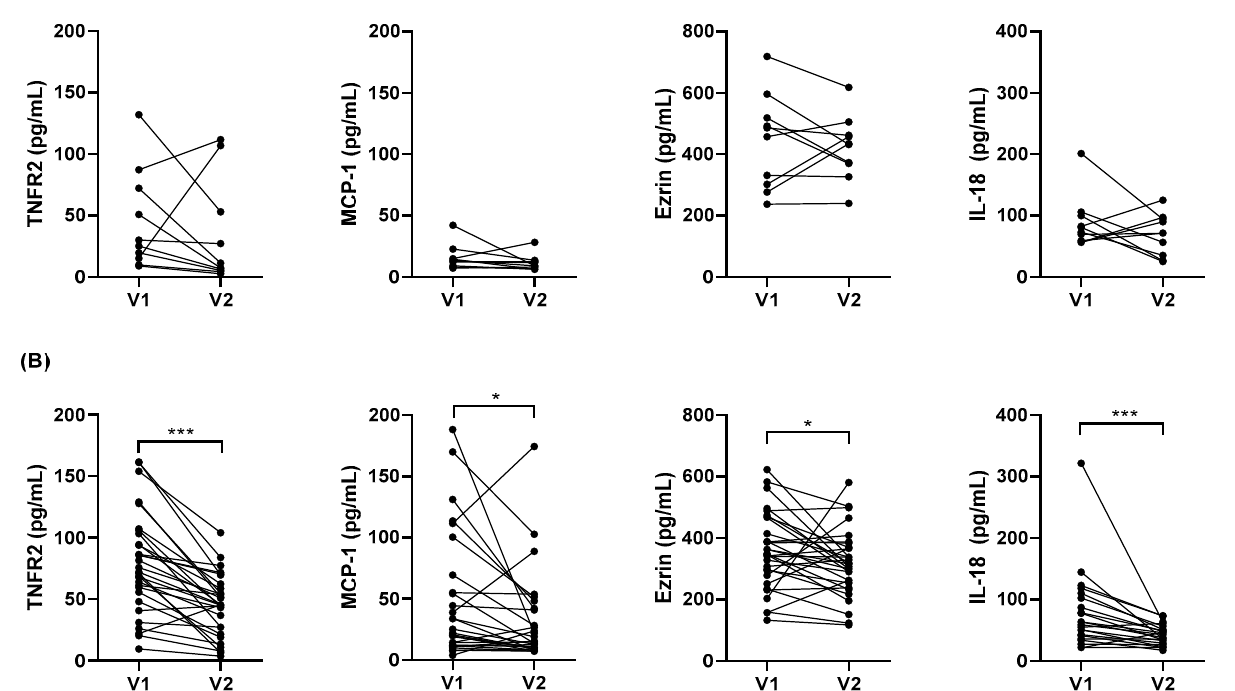
Figure 4. Serum TNFR2, MCP-1, Ezrin, and IL-18 level comparison between asthmatic subjects with obesity ( A ) and obese subjects without asthma ( B ) before (V1) and after (V2) bariatric surgery. Data presented as individual values. * p < 0.05, *** p ≤ 0.001; Wilcoxon test.